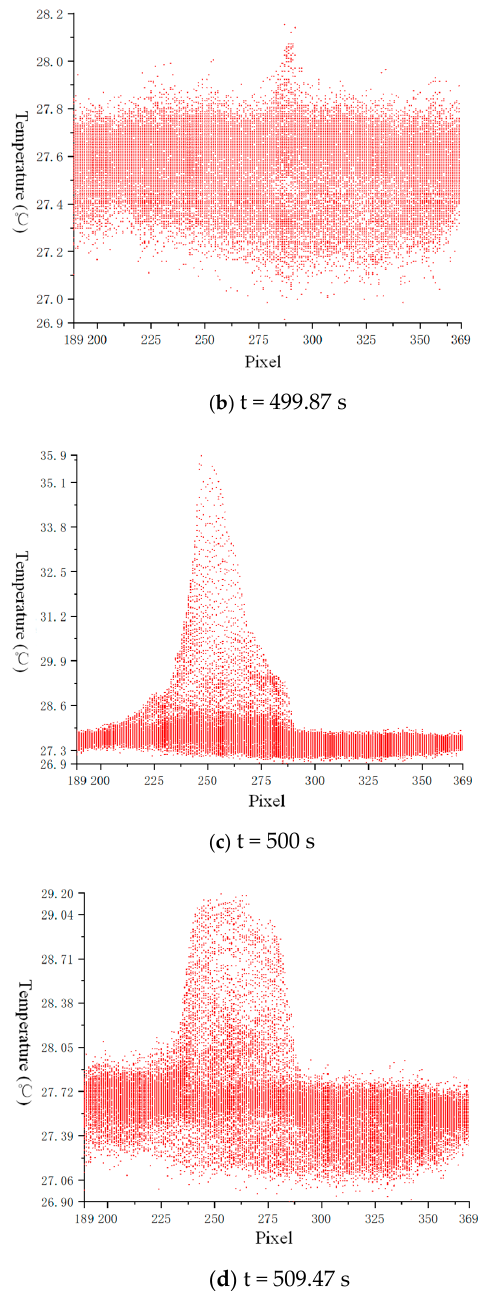
Figure 7. The oscillogram of the temperature in the observation area at the critical moment of the DL1-3 sample destruction.